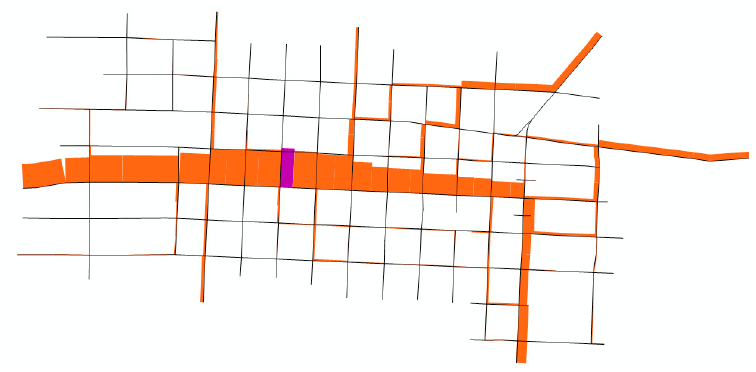
Figure 3. OD path flows that were intercepted by link L 1 . 5.